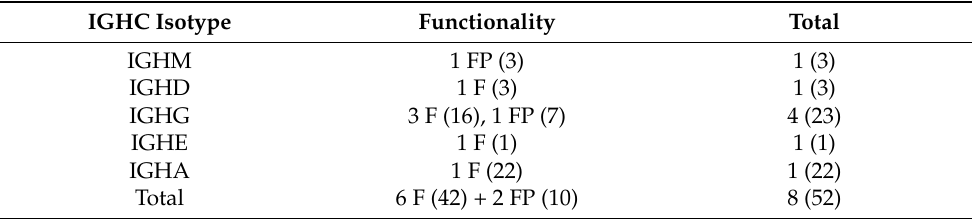
Table 6. For each IGHC isotype, number of IGHC genes per functionality and, between parentheses, number of alleles are shown. IGHC